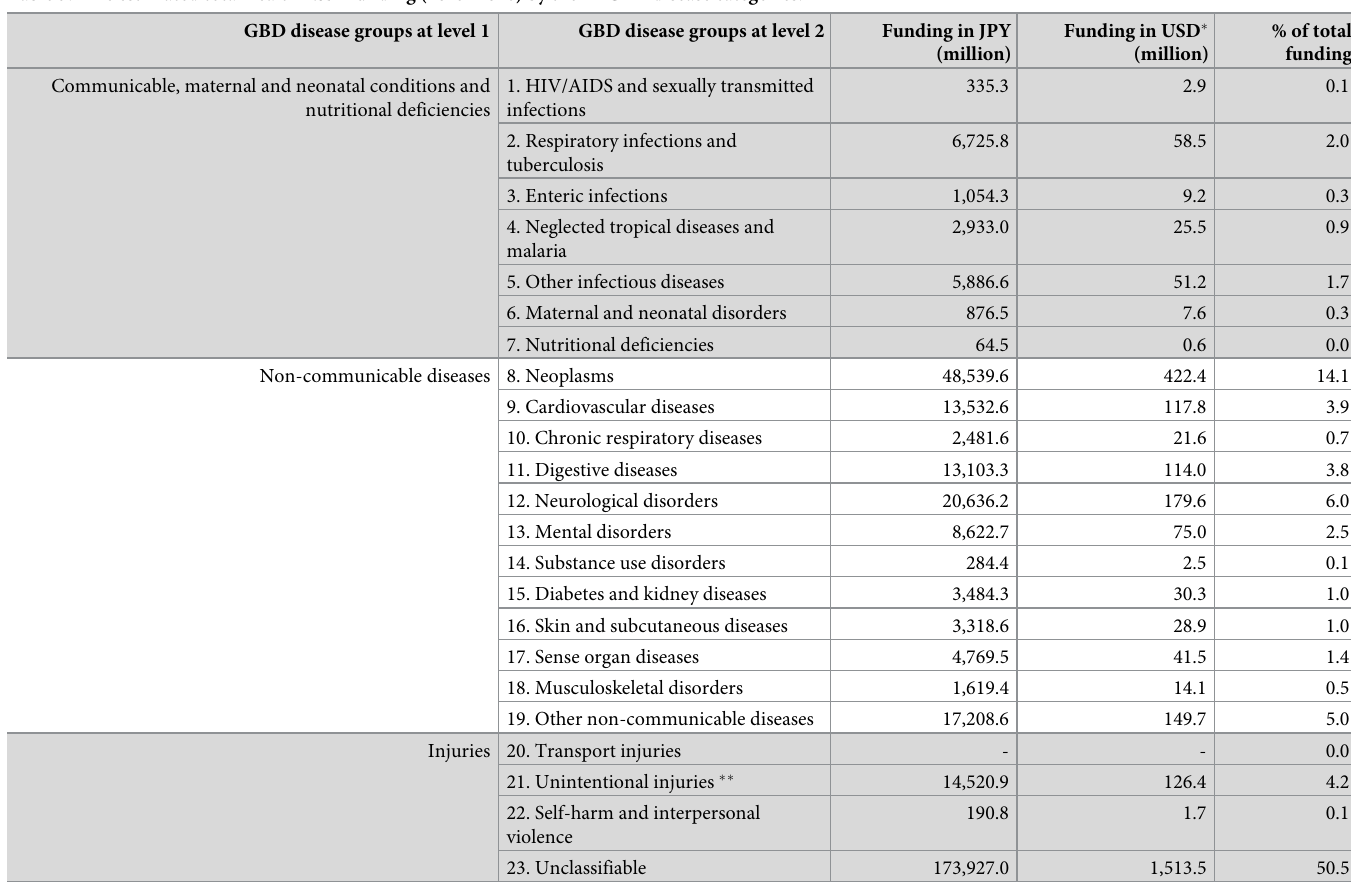
Table 3. The estimated total health R&D funding (2015–2016) by the 22 GBD disease categories. GBD disease groups at level